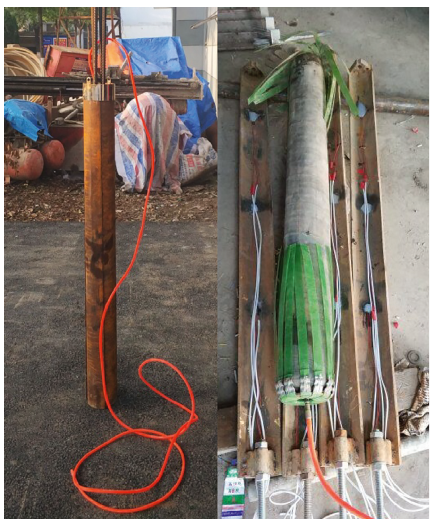
Figure 4: Photograph of the inflatable retrievable anchor.